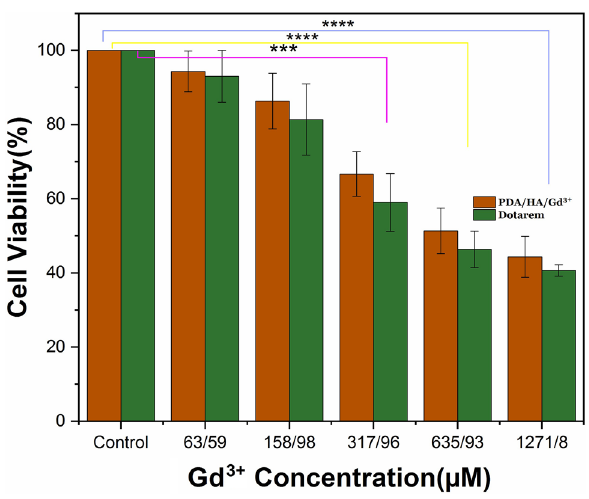
Figure 8. The cytotoxicity of Gd 3+ ions adsorbed on PDA/HA/NPs on HEK293 cells using MTT assay. Data are demonstrated as mean ± SD (n = 3). The significant difference levels are shown with asterisks compared to the negative control (**** and *** means p -value less than 0.0001 and 0.001, respectively).